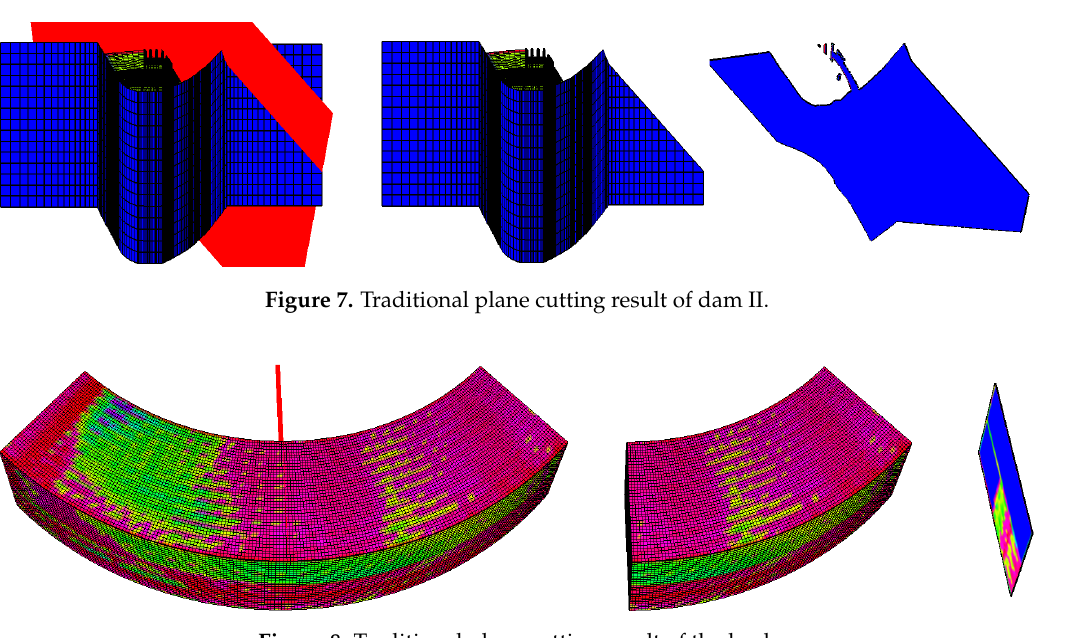
Figure 8. Traditional plane cutting result of the